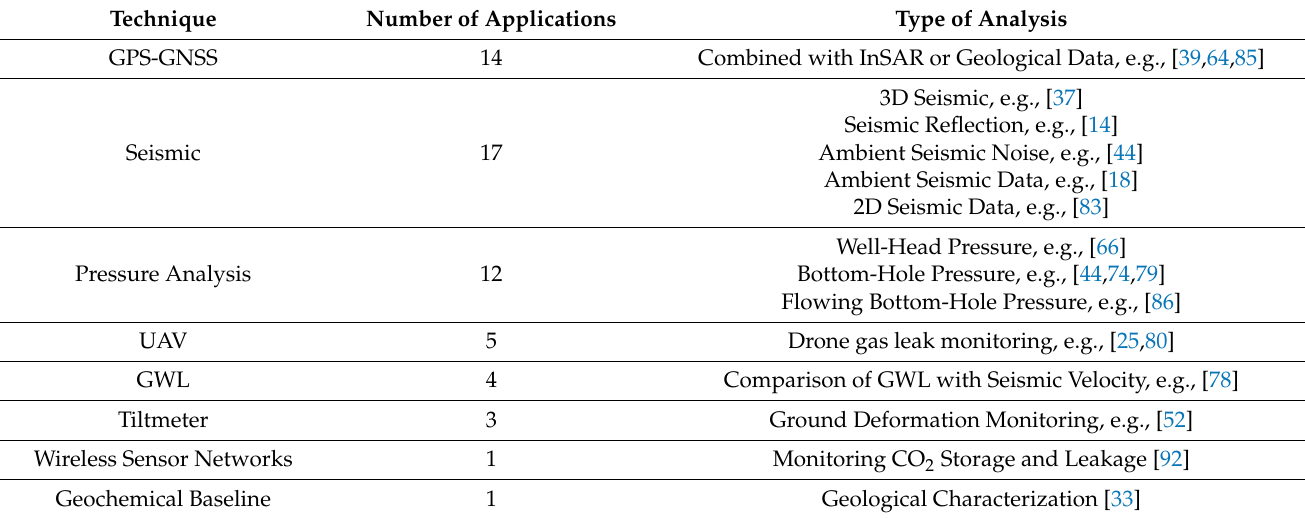
Table 1. Summary of the reference papers for each gas storage monitoring